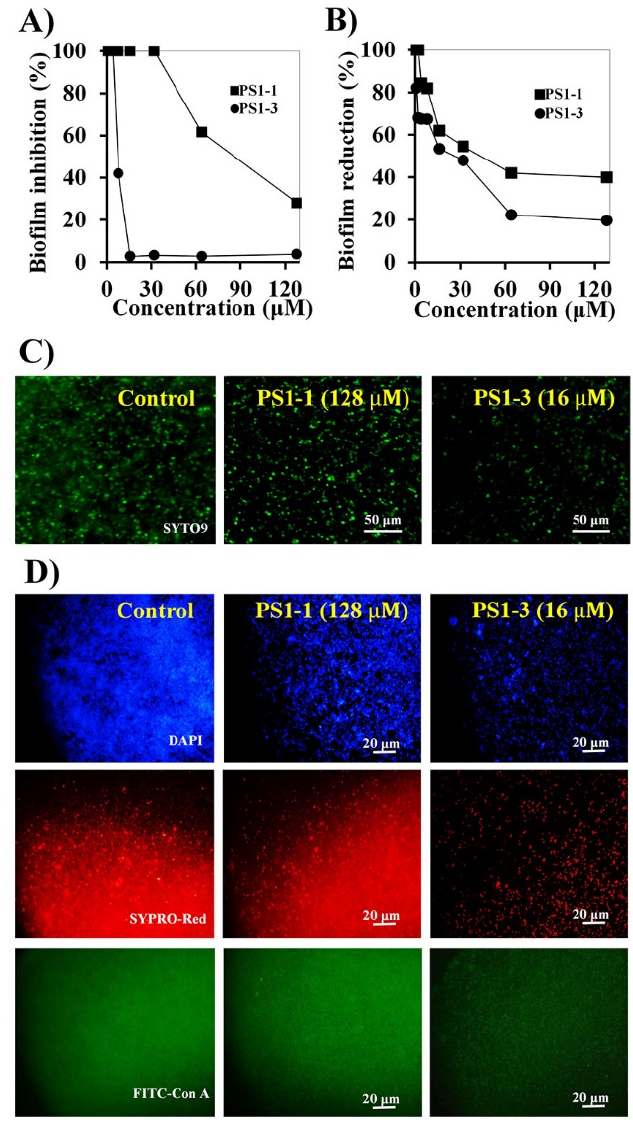
Figure 4. Anti-biofilm activity of PS1-1 and PS1-3. Biofilm inhibition ( A ) and reduction ( B ) in C. albicans CCARM 14007 cells strain by treating PS1-1 and PS1-3 peptides. Fluorescence microscope images of PS1-1 (128 μ M)- and PS1-3 (16 μ M)-treated cells indicated biofilm inhibition ( C ) and biofilm reduction activity ( D ).